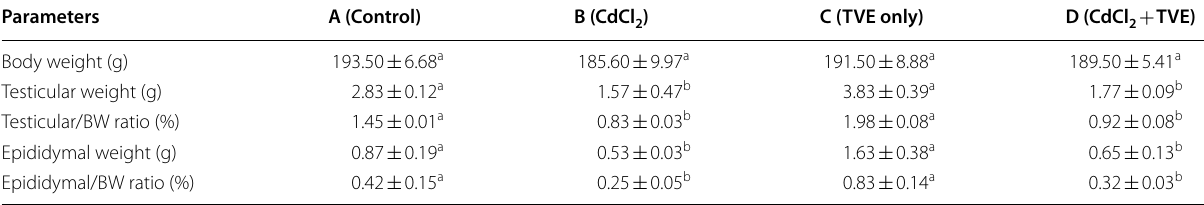
Values are Mean S.E.M, n 8; BW, body weight; g, gram; CdCl 2 , Cadmium chloride; TVE, Thymus vulgaris extract. Mean values bearing different superscripts in the ± = same row differ significantly at p 0.05 ≤